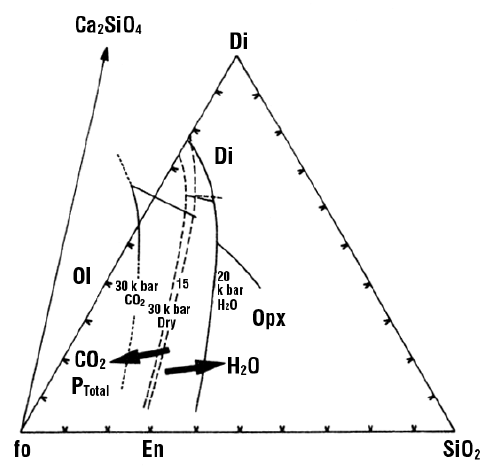
Fig. 5. Phase relations in the system diopside-